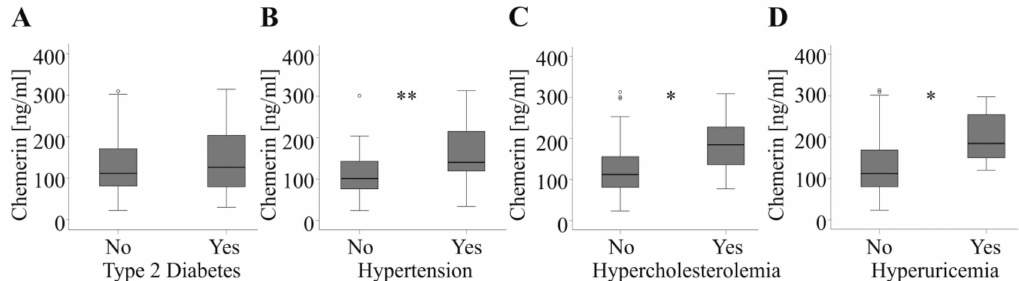
Figure 2. Serum chemerin and comorbidities in tumor patients. ( A ) Chemerin in 21 patients with and 47 patients without type 2 diabetes. ( B ) Chemerin in 34 patients with and 34 patients without hypertension. ( C ) Chemerin in 11 patients with and 57 patients without hypercholesterolemia. ( D ) Chemerin in seven patients with and 61 patients without hyperuricemia. * p < 0.05, ** p <